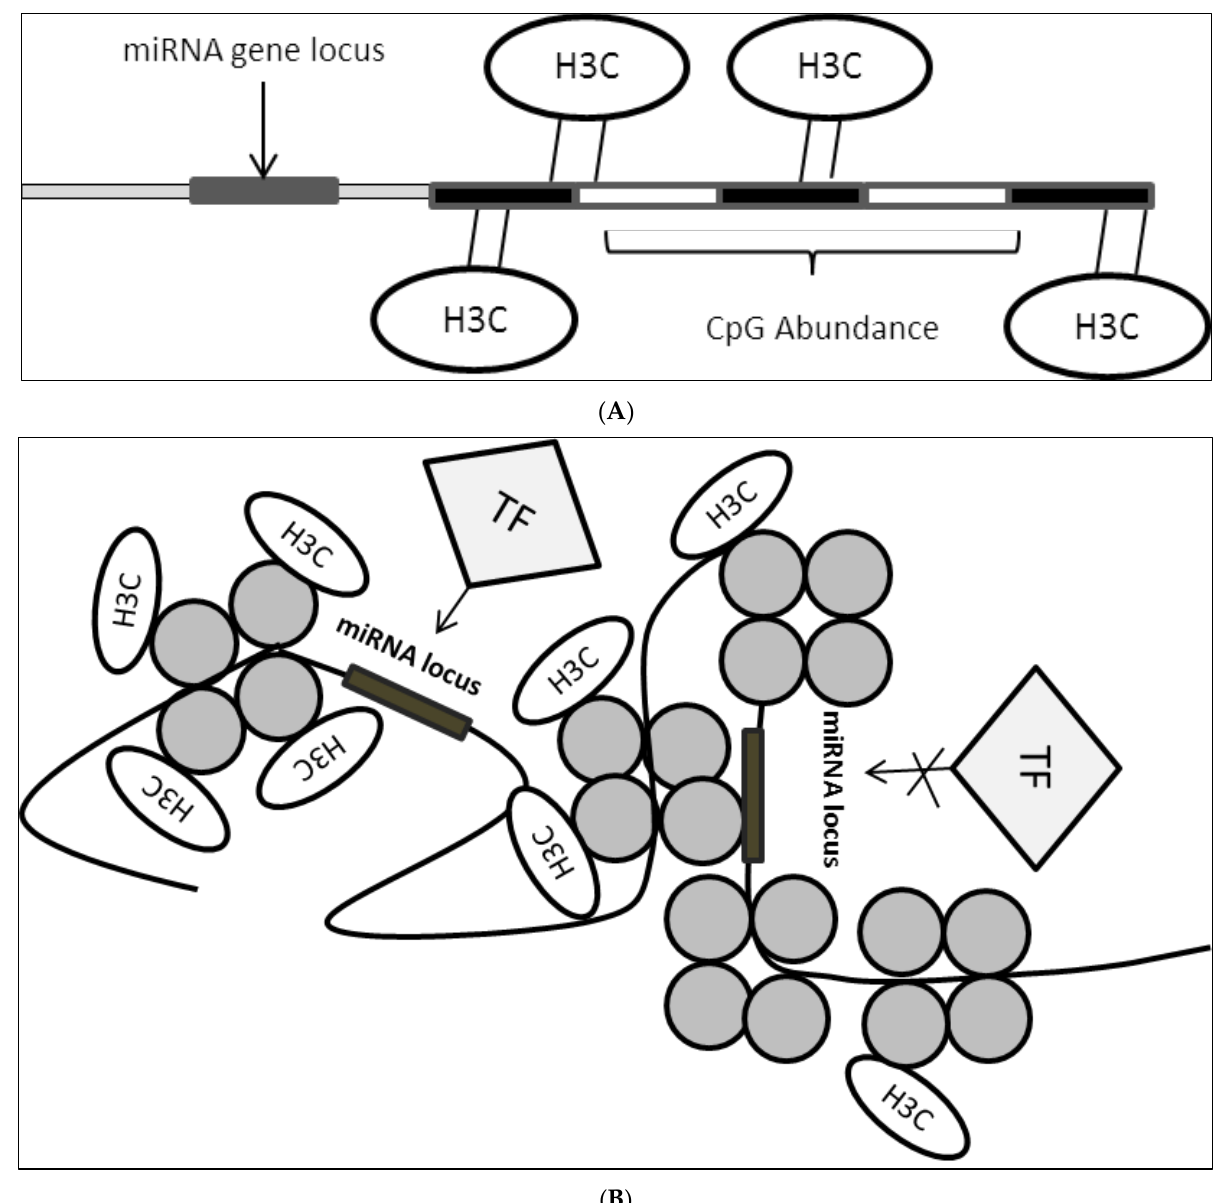
Figure 3. ( A ): CpG site enrichment on miRNA locus resulting in miRNA suppression. CpG methylation brought about by DNMTs methylates DNA sequence in proximity to miRNA locus or direct locus methylation leads to suppression of miRNA expression. H3C: methyl group; ( B ): Histone state on miRNA locus controls accessibility of TFs. Histone modifi- cation leads to the formation of open or closed chromatin structure which in turn affect TFs binding onto miRNA locus where this would result in either miRNA activation or suppression depending on the transcriptional activity of the bounded factors. H3C: methyl